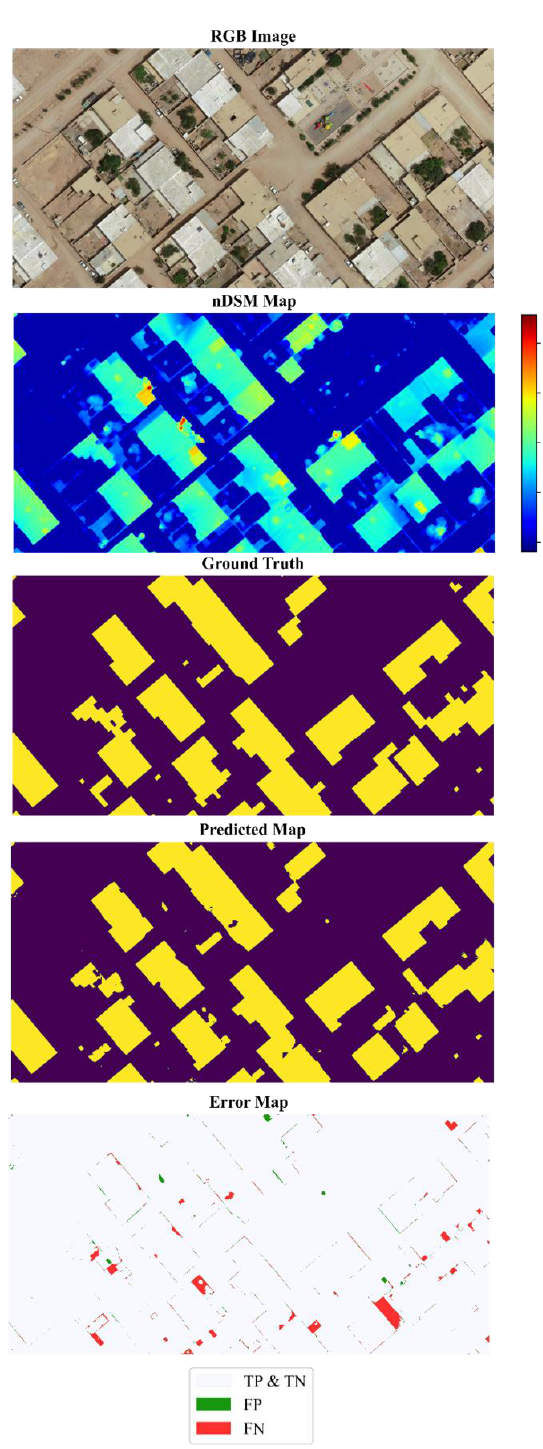
Figure 7 . The error map between the ground truth and the predicted map using the RGBD model for the sample area